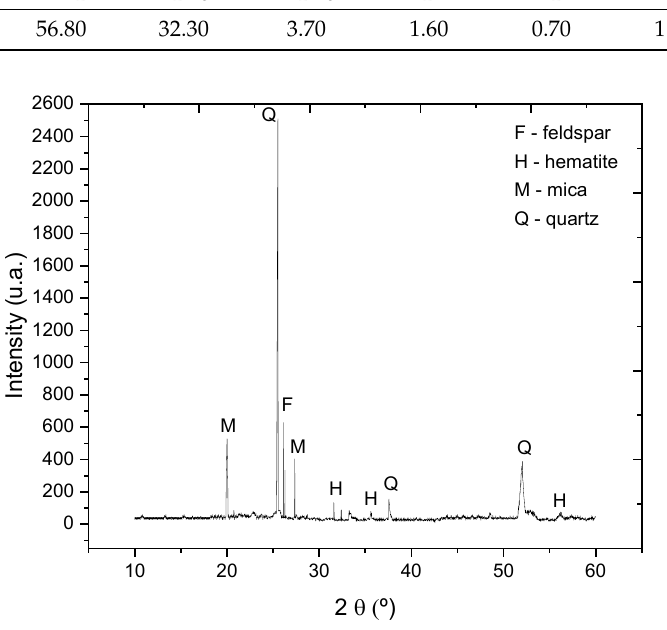
Figure 2. X-ray Diffraction (XRD) pattern of waste CCW sample.